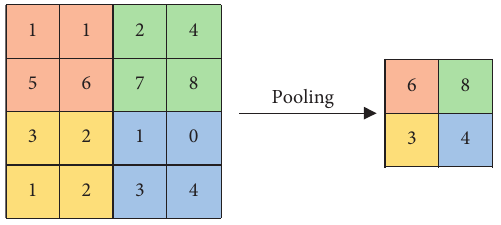
Figure 7: Pooling operation.